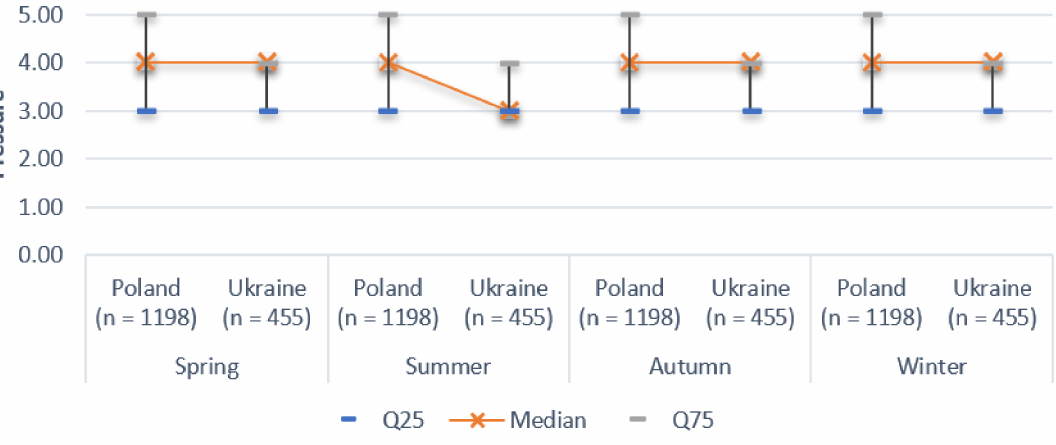
Figure 8. Assessment of tap water pressure during individual periods of the year by groups of respondents from Poland and Ukraine.